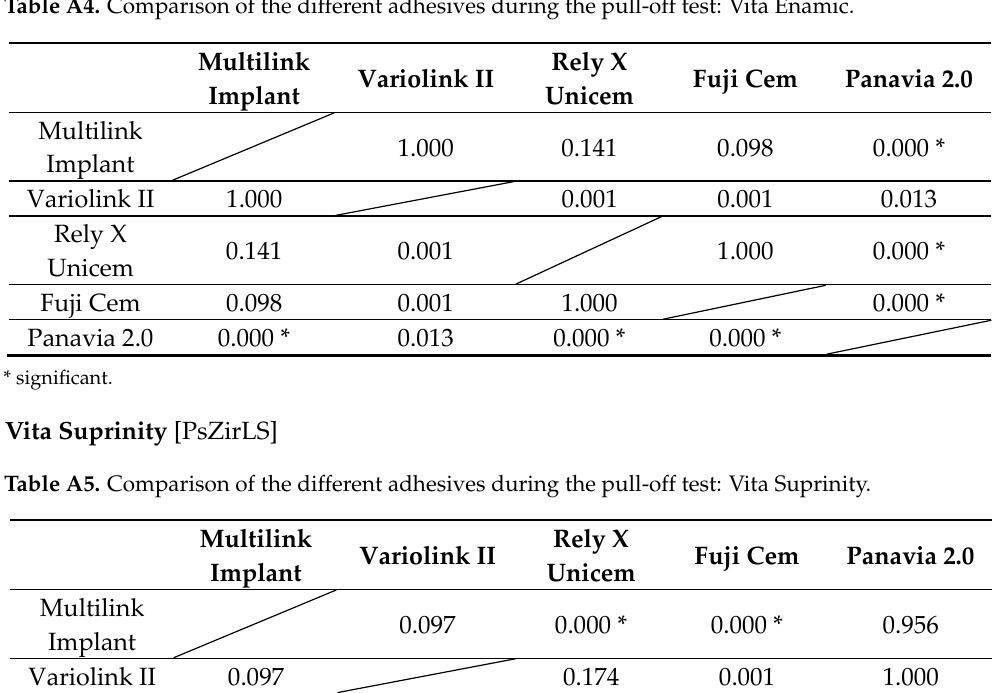
Table A4. Comparison of the different adhesives during the pull-off test: Vita Enamic.